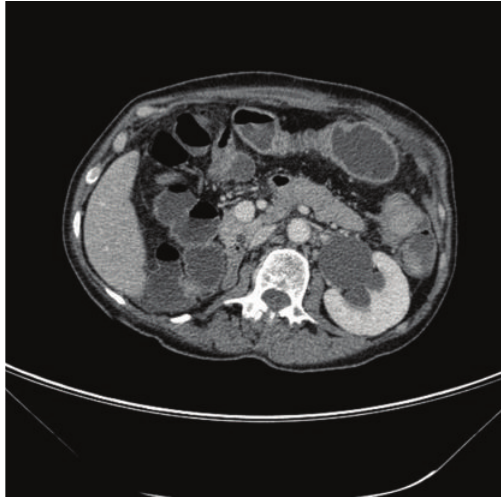
Figure 4: Small bowel mucosa infiltrated by cords of metastatic lobular adenocarcinoma cells. (Haematoxylin and eosin, original magnification ×